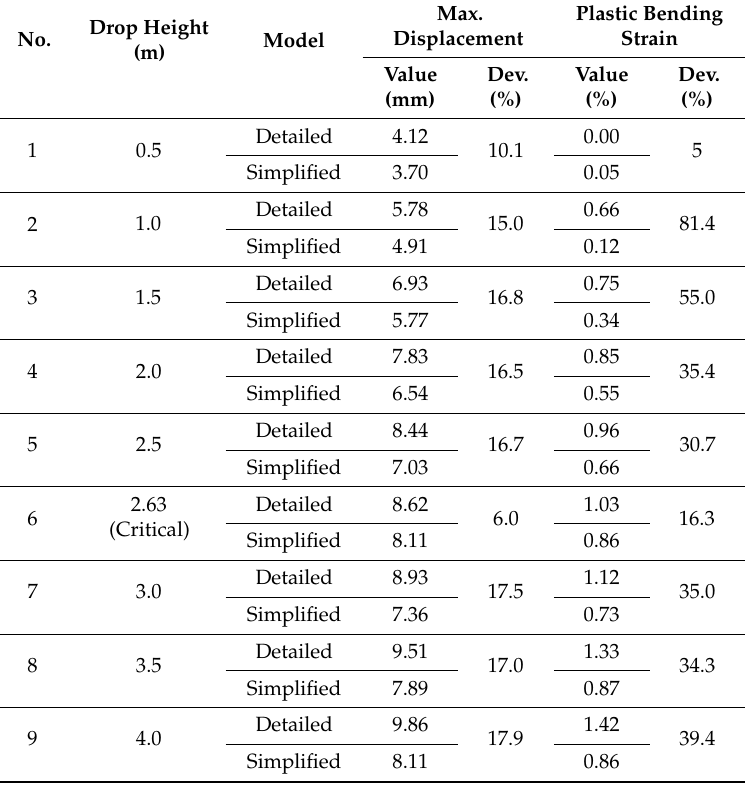
Table 7. Results of the impact analyses for the fully de-bonded